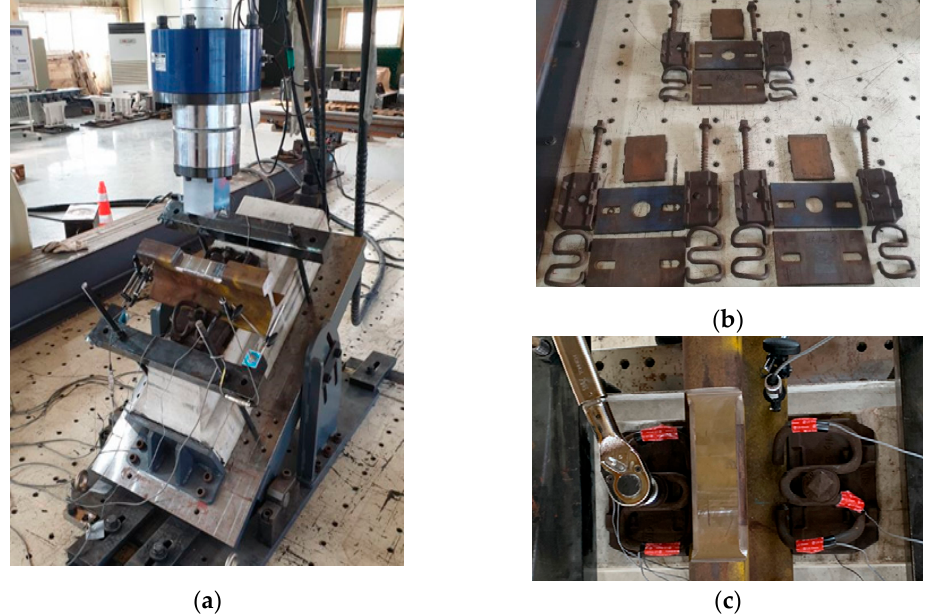
Figure 5. Images of laboratory test. ( a ) Inclination test; ( b ) specimen with 16 years of service; ( c ) introduction of clamping force.